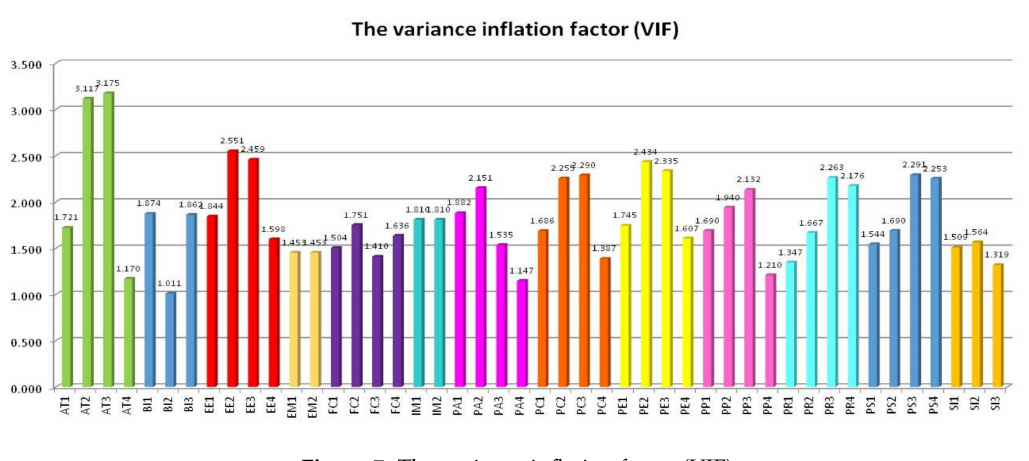
Figure 7. The variance inflation factor